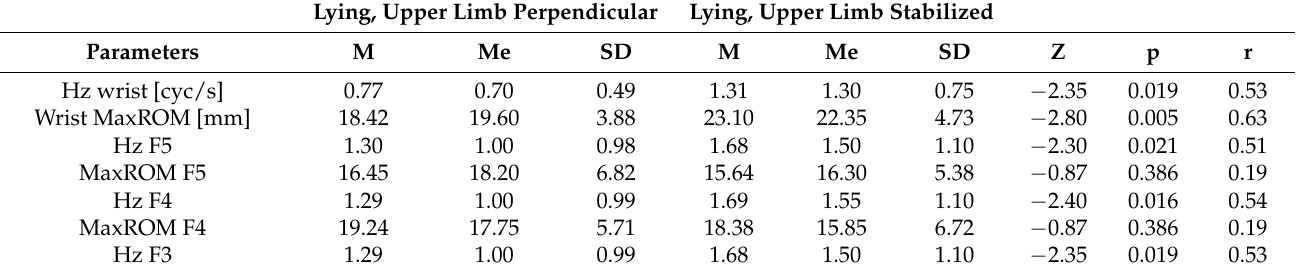
Table 8. Comparison of the parameters of movement and strength in the lying positions with the upper limb and against the body in the group of patients after hemorrhagic stroke. Lying, Upper Limb Perpendicular Lying, Upper Limb